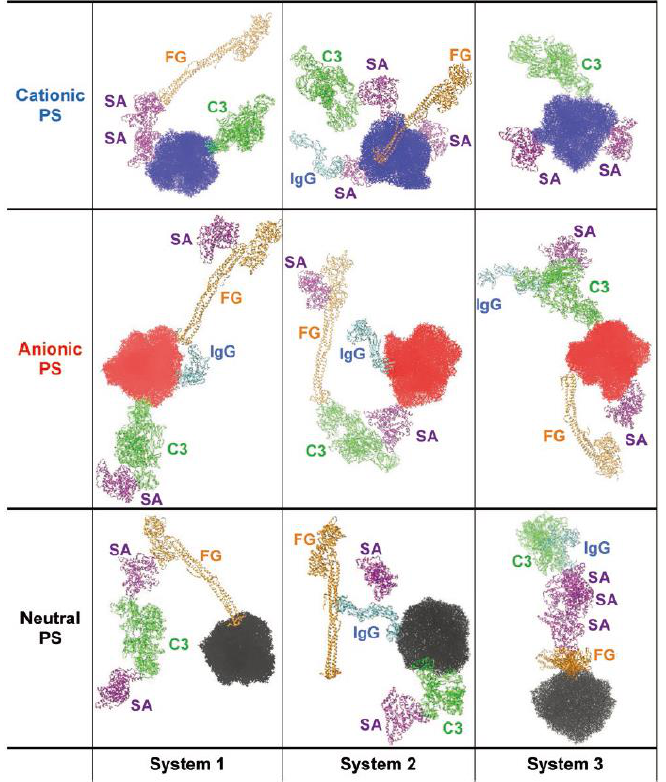
Figure 9. Final snapshots of simulations showing the self-assembly of plasma proteins randomly adsorbed onto cationic, anionic, and neutral PS nanoparticles. Reproduced with permission from [57], WILEY-VCH, 2020.